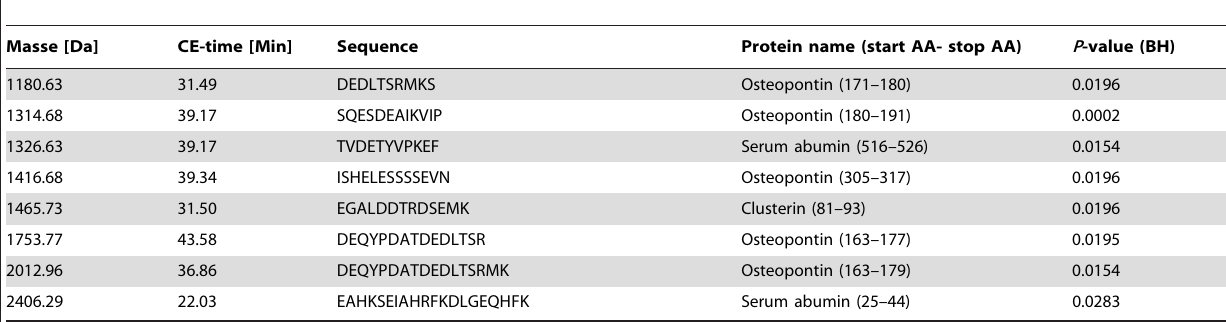
Table 2. Significantly changed fragments of serum albumin, osteopontin and clusterin by gentamicin induced kidney injury in